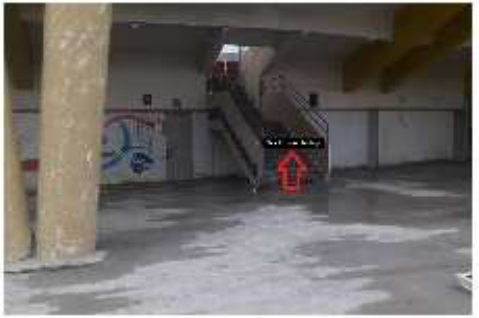
source information and QR on the ticket can be scanned for seat information. The subsection of Get Path is to show path for the nearest desired amenity from a source that can again be detected from user’s location or be manually en- tered. The three buttons at the bottom are submit buttons that send request to the server. The Show Path renders the map to the user along with markers that help users reach the destination. The Autoplay Path too renders the map but autoplays the entire path to the user without having the user to click on markers. The Clear Path button clears the fields entered above and refreshes back to the start page of the